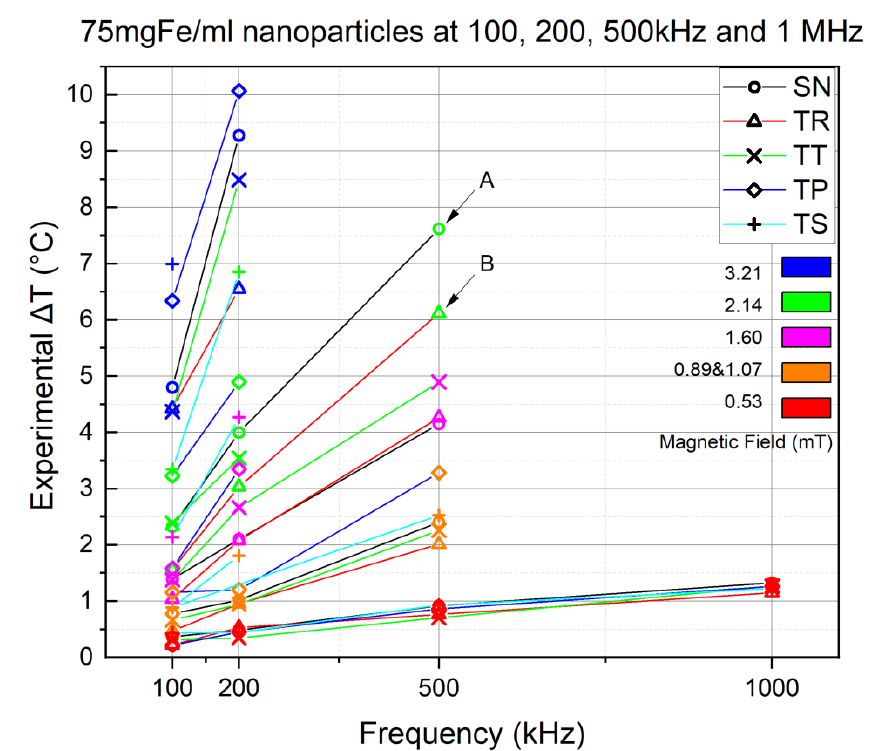
Figure 9. Frequency effect experiments result of 75 mgFe/mL MNPs at frequencies going from 100 kHz to 1 MHz for 900 s at B going from 0.5 to 3.2 mT.